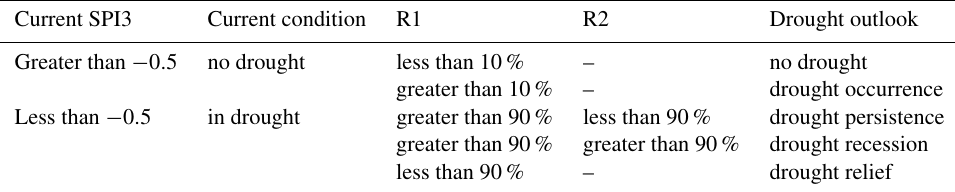
Table 7. Specific rules for drought outlook based on angle comparison. R1 represents the ratio of days when α i is less than the critical angle α 1 i (α 3 i ) to the total 90 days. R2 represents the proportion of specific days in the period to the predicted prospective 46–90 days. In R2 calculation, these specific days meet the criteria that α i is greater than critical angle α 3 i .